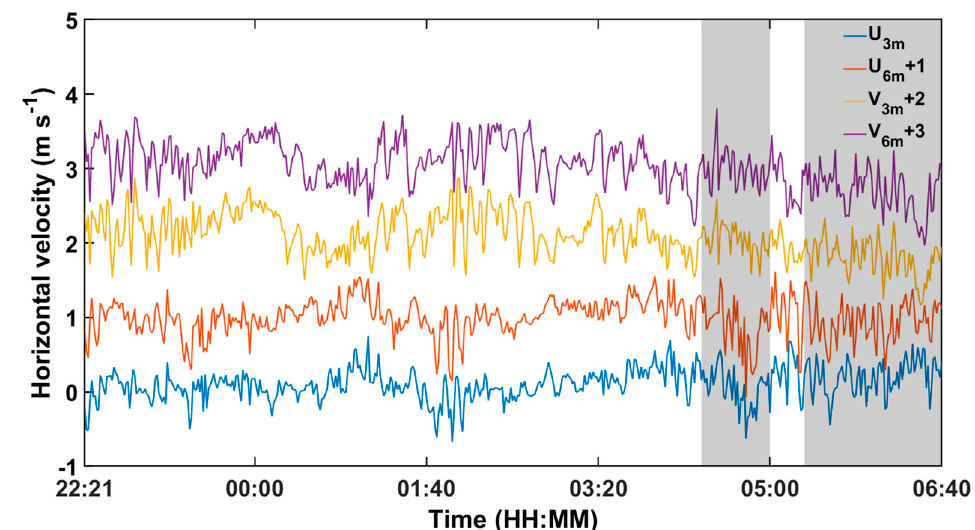
Figure 6. Same as Figure 4, except for 2220 27 Oct. 2017–0640 28 Oct. 2017 in Case 6.